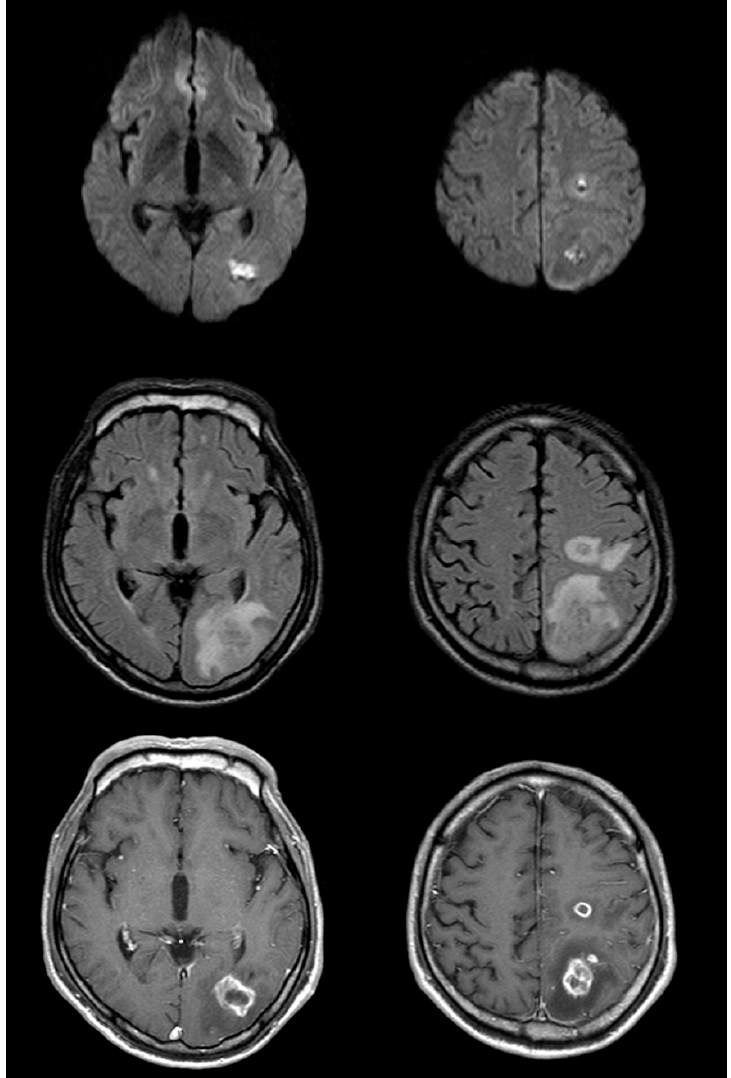
Figure 2. Follow up brain magnetic resonance imaging on the eleventh day after symptom onset (top row: diffusion-weighted imaging (DWI); middle row: fluid-attenuated inversion recovery (FLAIR); bottom row: post-gadolinium). There is significant interval change with enlargement of the lesions on DWI and FLAIR images, as well as significant vasogenic edema. Post-gadolinium T1-weighted images show somewhat thick and irregular but complete ring enhancement.